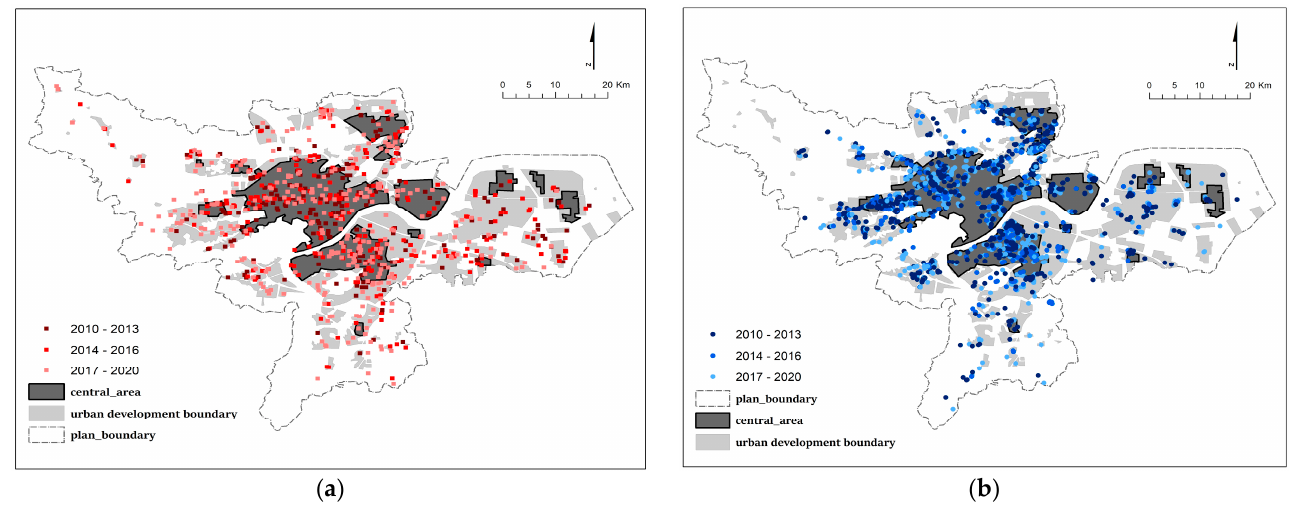
Figure 4. The distribution of development projects of Hangzhou (2010–2020) ( a ) Profit-use projects; ( b ) public projects. Table 1. Conformance between the urban planning and projects on leased land.